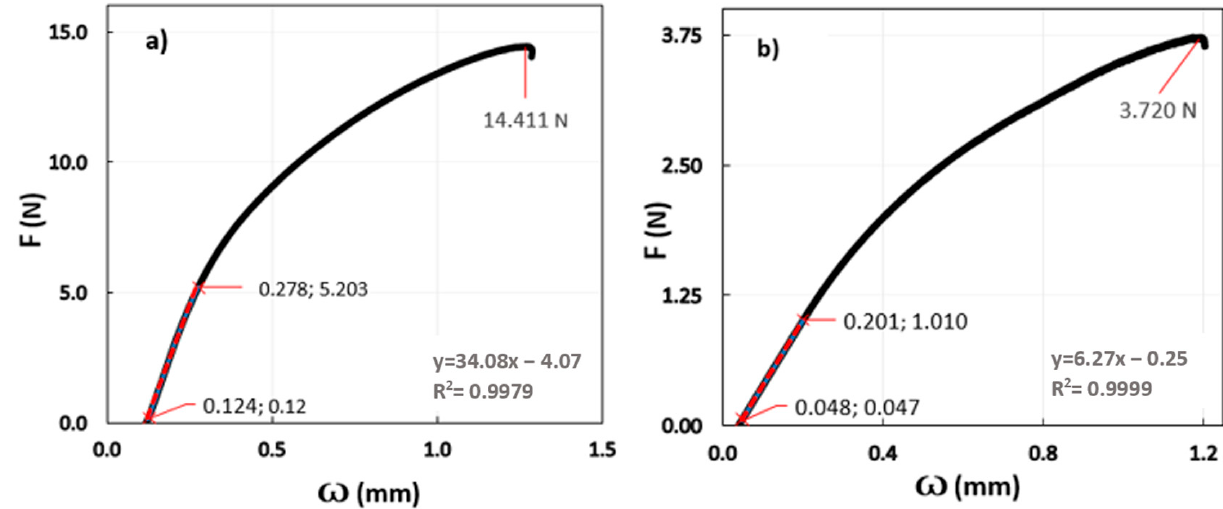
Figure 3. Three-point flexural test diagrams: ( a ) Sample 1 and ( b ) Sample 2. Table 4. Modulus of elasticity and hardness values for Sample 1 and Sample 2.